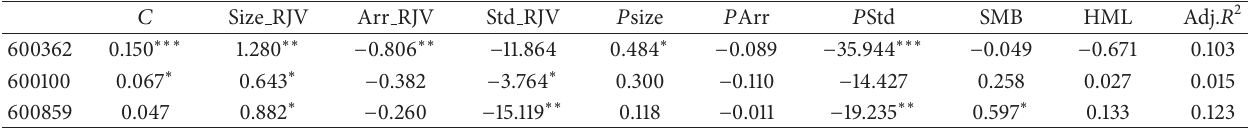
Table 9: Forecasting one-month-ahead individual returns using realized jump volatility-based factor model with FF factors.